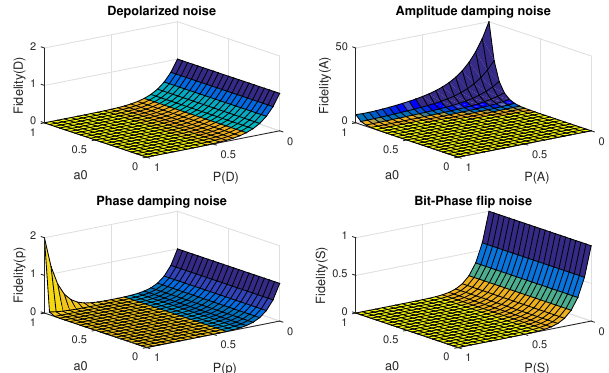
Figure 7. The variations of the fidelity in different noise with different coefficients of the initiated state and decoherence rate, where P(D) is short for the decoherence rate of the depolarized noise, P(A) is short for the decoherence rate of the Amplitude damping noise, P(p) is short for the decoherence rate of the phase damping noise, P(S) is short for the decoherence rate of the bit-phase flip noise. Suppose the coefficient of the desired state is a 0 = a 1 = b 0 = b 1 = c 0 = c 1 ∈ [ 0,1 ]